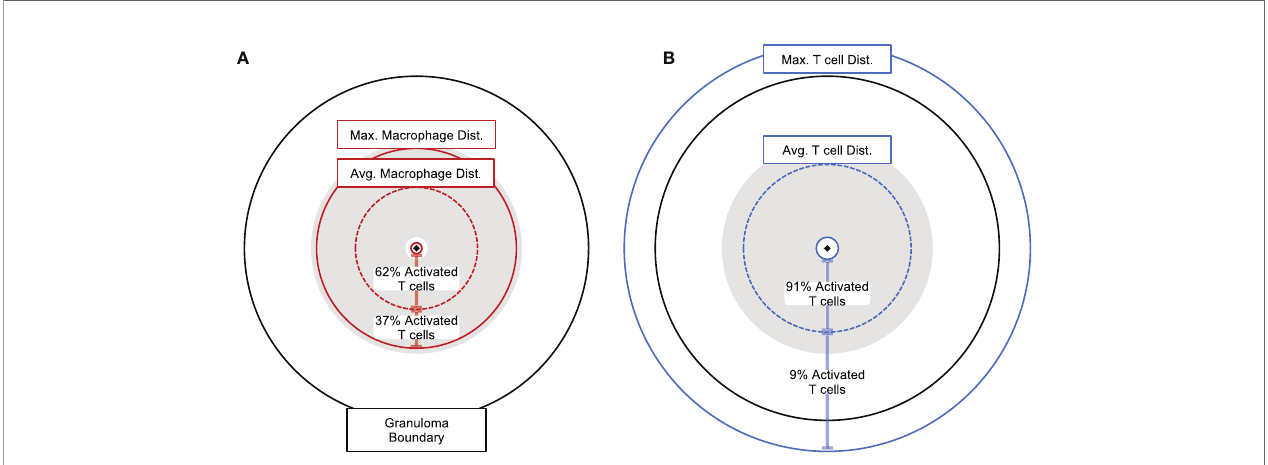
FIGURE 6 | Spatial analysis of granulomas showing distances between macrophages and T cells. Proportional distances of average maximum, and minimum (A) activated macrophages presenting antigen or (B) Mtb-speci fi c T cells from the granuloma center of mass (7-weeks post infection). Maximum and minimum distances shown as solid circles, average distances show as dotted circles. Gray shaded areas encompass all activated Mtb-speci fi c T cells present. Percent of all activated T cells is shown between minimum and average, as well as average and maximum distances for both (A) activated macrophages presenting antigen and